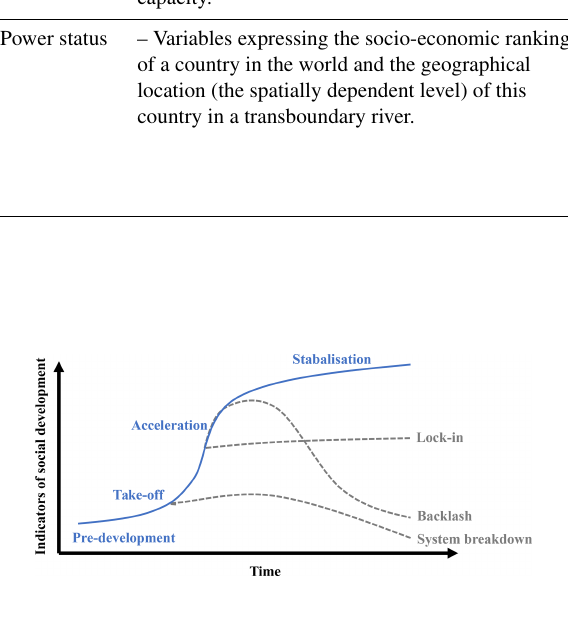
Figure 2. Stages and possible pathways of the development of a societal system (adopted from Rotmans et al., 2001, and Rotmans,